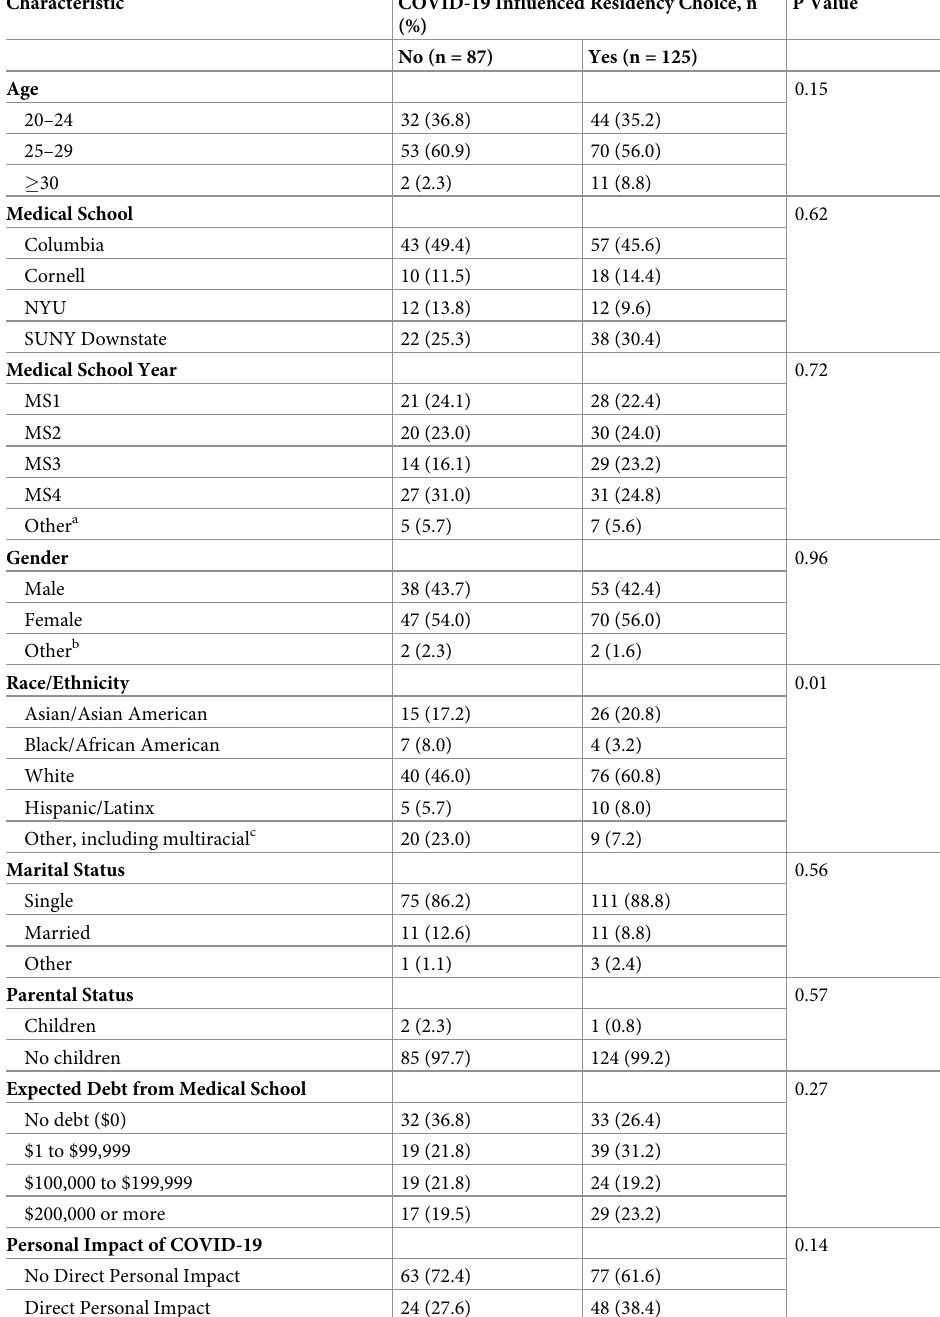
Table 2. Univariable analysis of factors impacting residency choice During COVID-19, in 212 New York City medical